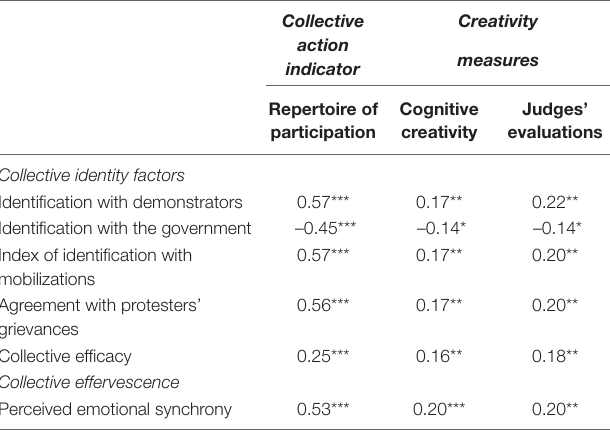
TABLE 2 | Correlations of collective identity factors and perceived emotional synchrony with collective action variables and creativity